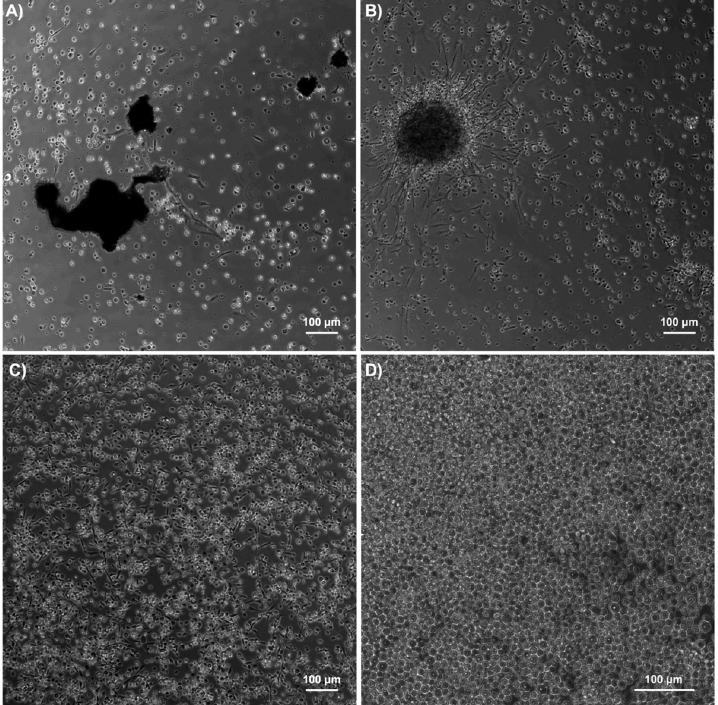
Figure 4 . Microscopic images of hemocyte cultures. ( A ) Culture with melanized areas shown in black. ( B ) Culture with a large cell aggregate. ( C ) Culture with cells attached to the well. ( D ) Optimized culture where there are no clumps or melanization due to the use of both L-cysteine and the anticoagulant solution. All images belong to different cultures on Day 1 of observation. Images ( A – C ) were taken at a magnification of 10 × , while image ( D ) was taken with a magnification of 20 ×